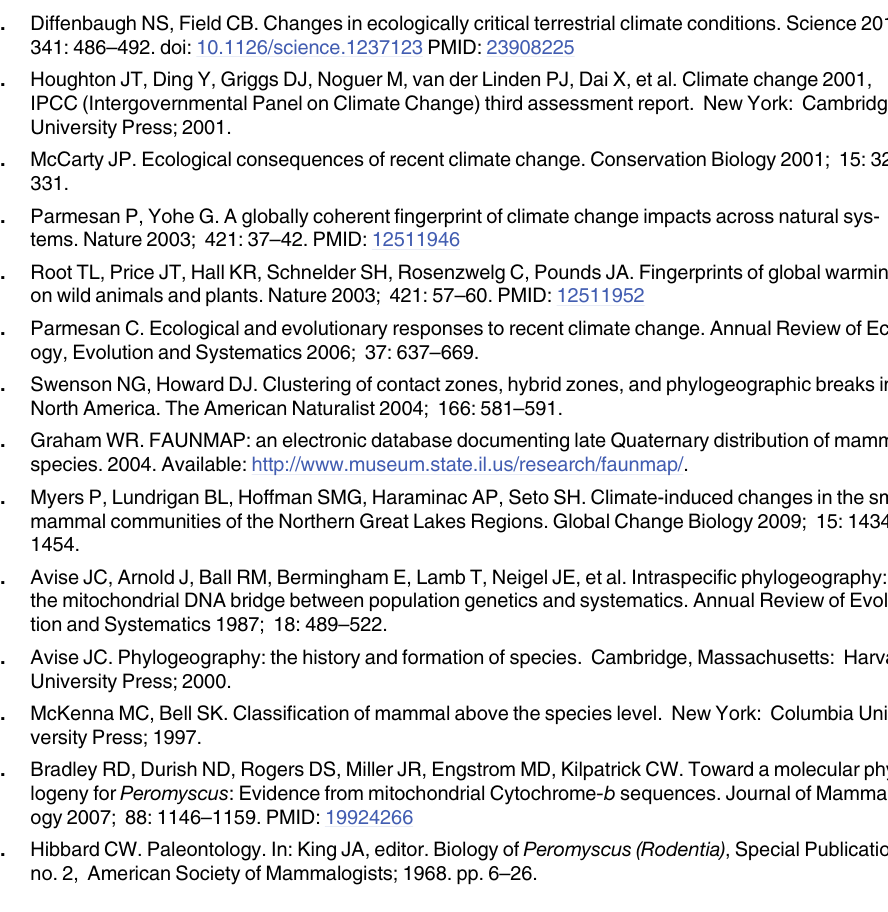
S4 Table. Pairwise Fst values (above diagonal) and corresponding probabilities (below diagonal) among the 13 populations of Peromyscus maniculatus sampled in this study. Sig- nificant Fst values are in